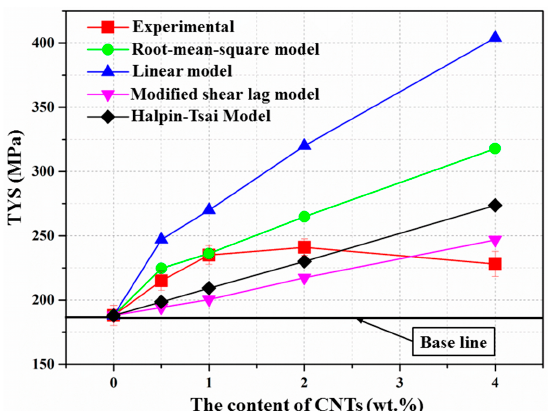
Figure 8. Plots of yield strength of the composites theoretically predicted by different models and experimentally obtained in this study.